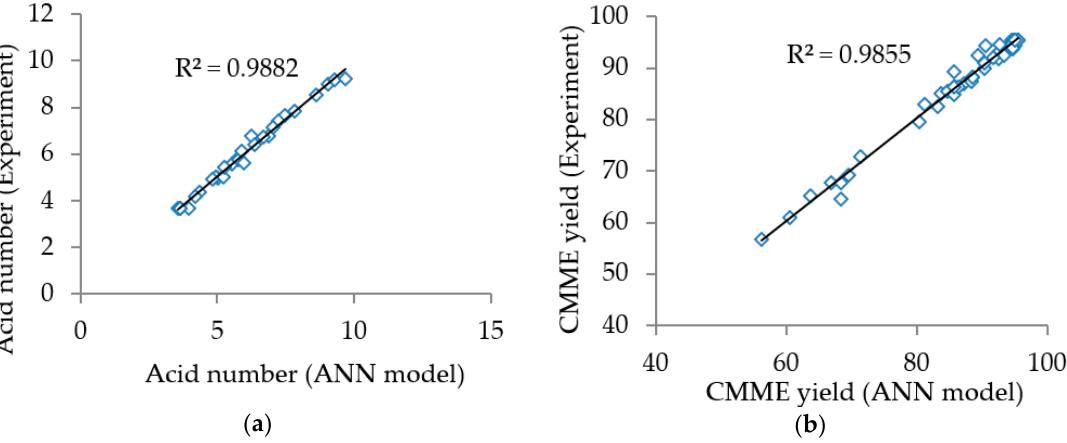
Figure 2. Experimental values versus values predicted by the ANN model integrated with ant colony optimization (ACO) for ( a ) acid-catalyzed esterification (acid number) and ( b ) base-catalyzed transesterification [ C. manghas methyl ester ( CMME ) yield].